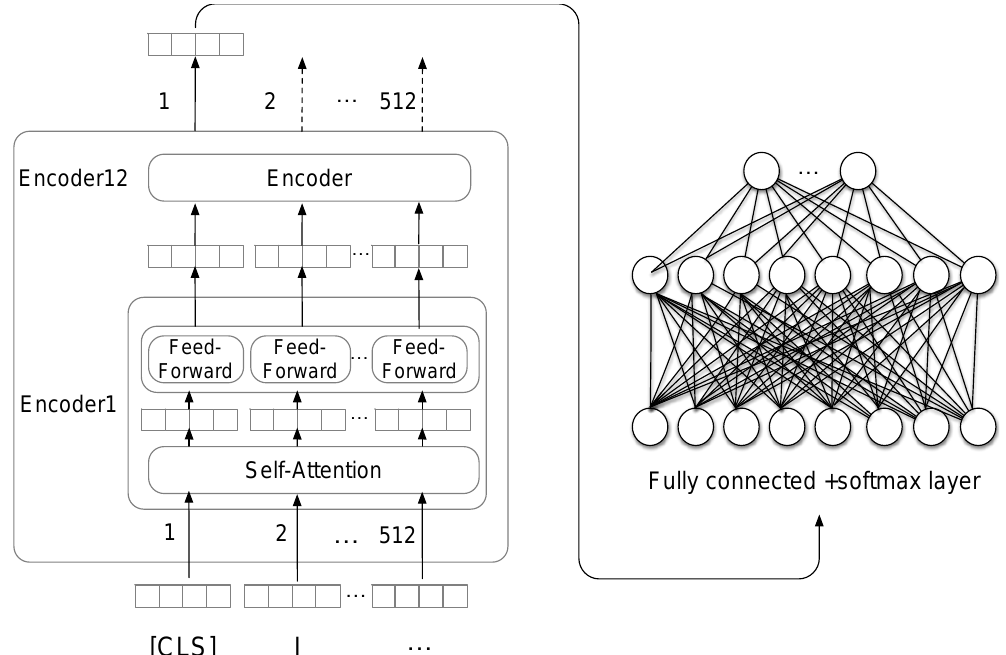
Figure 5. The architecture of fine-tuning bidirectional encoder representations from transformers